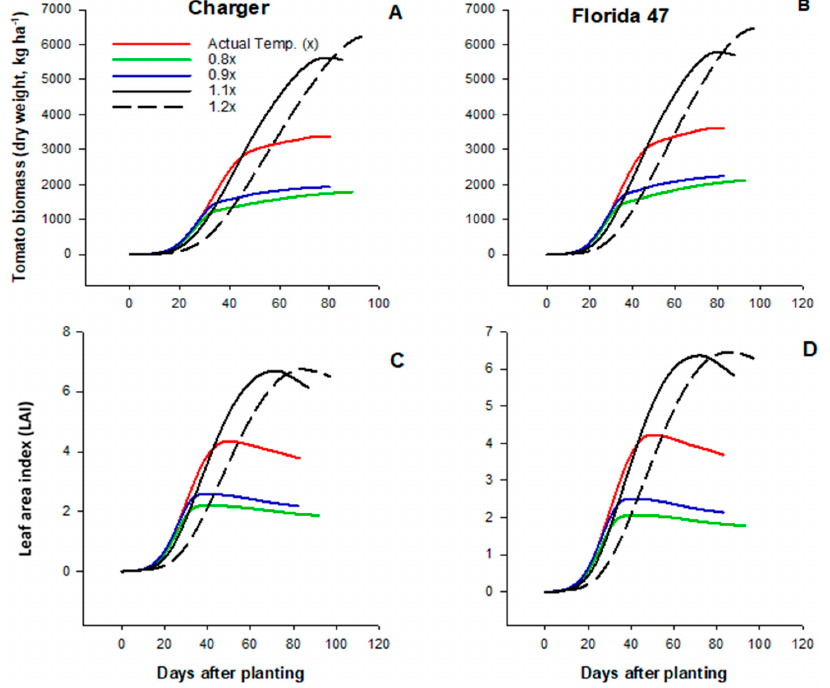
Figure 6. Effects of variations in air temperature on tomato biomass production ( A and B ) and leaf area index ( C and D ) of two drip irrigated commercial fresh market tomato varieties (Charger and Florida 47) in Immokalee Florida.